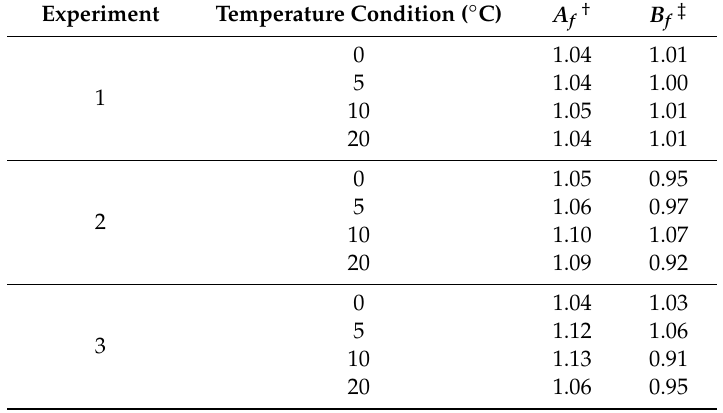
Table 4. Comparison of accuracy and bias factors of the predictive models from experiments 1 to